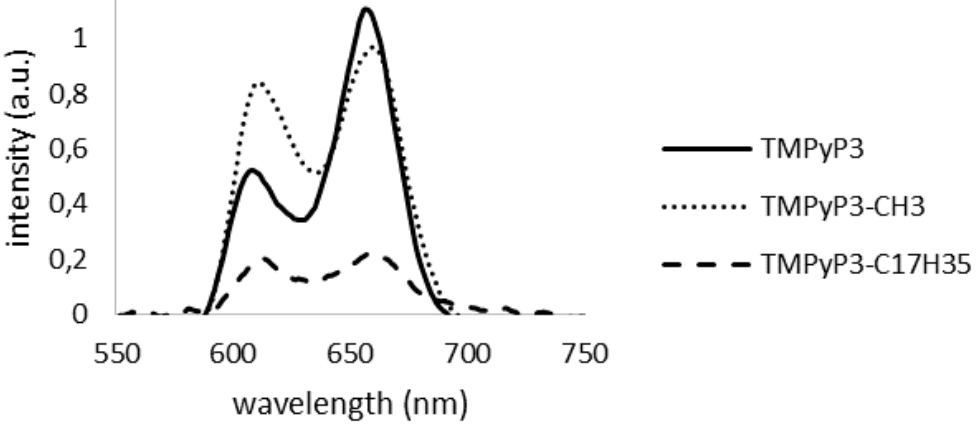
Table 2. Absorption and fluorescence emission characteristics of porphyrins TMPyP3, TMPyP3-CH 3 and TMPyP3-C 17 H 35 (10 µM) in tap water. Molar extinction coefficients ( ɛ ) were calculated using the Beer – Lambert law. Figure 2. Comparison of fluorescence spectra of TMPyP3, TMPyP3-CH 3 and TMPyP3-C 17 H 35 (2 µM) obtained by excitation at Soret band wavelength. All measurements were performed on tap water of the city of Rijeka.